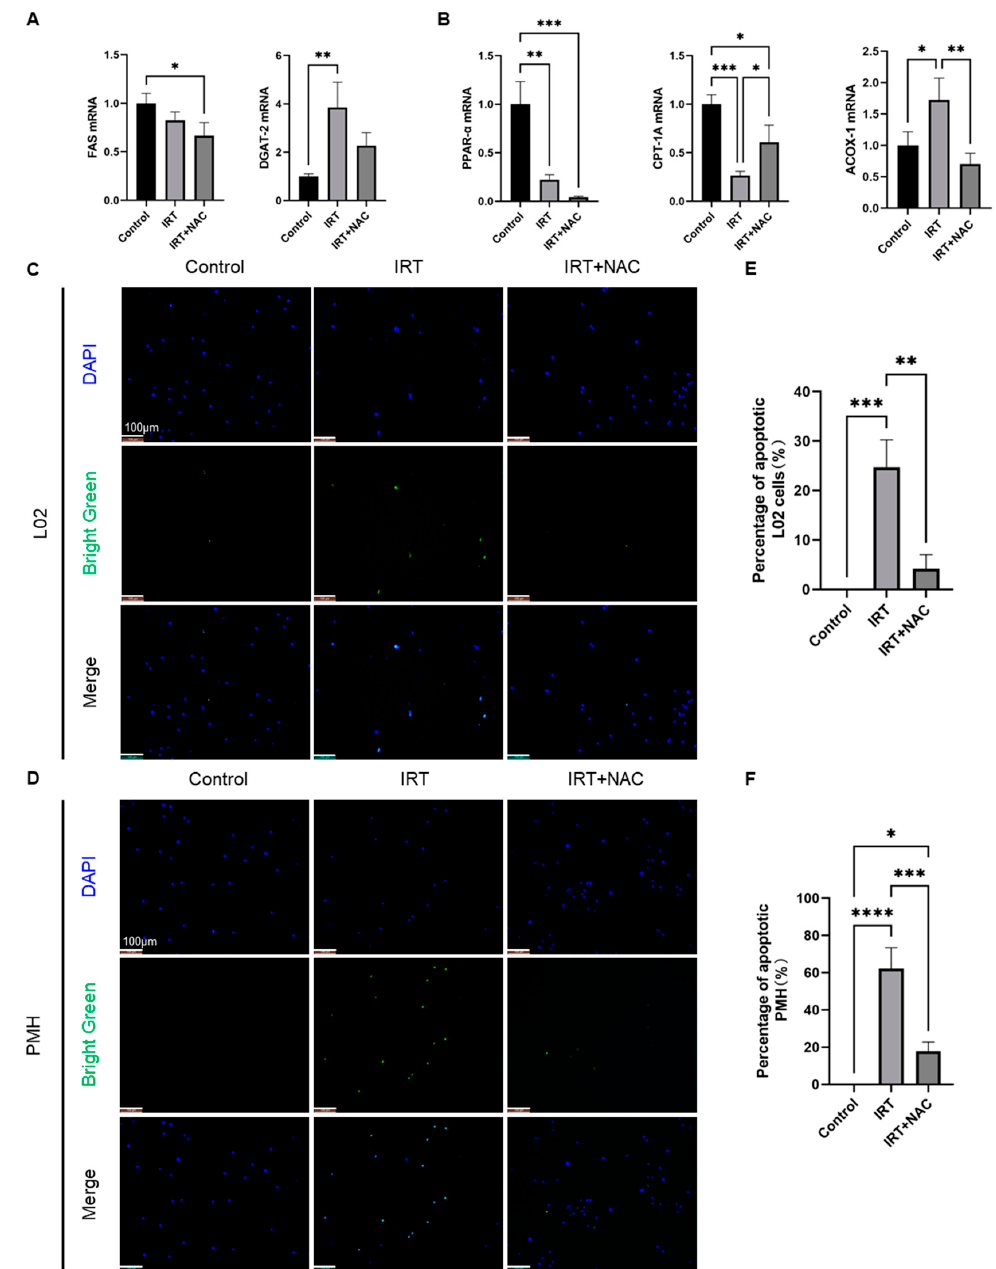
Figure 6. Irinotecan induced macrophage activation trigger lipid metabolism disorder and apoptosis in hepatocytes . ( A , B ) The macrophages were treated with irinotecan (10 μ M) in the absence or presence of NAC (600 μ M), and they were indirectly co ‐ cultured with hepatocytes, and the lower hepatocytes were used for TUNEL or qPCR. ( A ) Expression of mRNA levels of FAS and DGAT ‐ 2 in hepatocyte after NAC intervention. ( B ) Expression of mRNA levels of PPAR ‐α , CPT ‐ 1A, and ACOX ‐ 1 in hepatocytes after NAC intervention. ( C – F ) L02 cells ( C ) or PMH ( D ) were co ‐ cultured with THP ‐ 1 ( C ) or primary macrophages ( D ) treated with irinotecan (10 μ M) in the absence or presence of NAC (600 μ M). Cell death was evaluated by TUNEL assay. Quantitative analysis of changes in the percentage of apoptotic cells after irinotecan treatment and NAC intervention, respectively ( E , F ). Data are reported as mean ± SD, and each graph is representative of at least three independent ex ‐ periments. Statistical significance was tested with an unpaired t ‐ test and one ‐ way ANOVA. * p < 0.05; ** p < 0.01; *** p < 0.001; **** p < 0.0001.